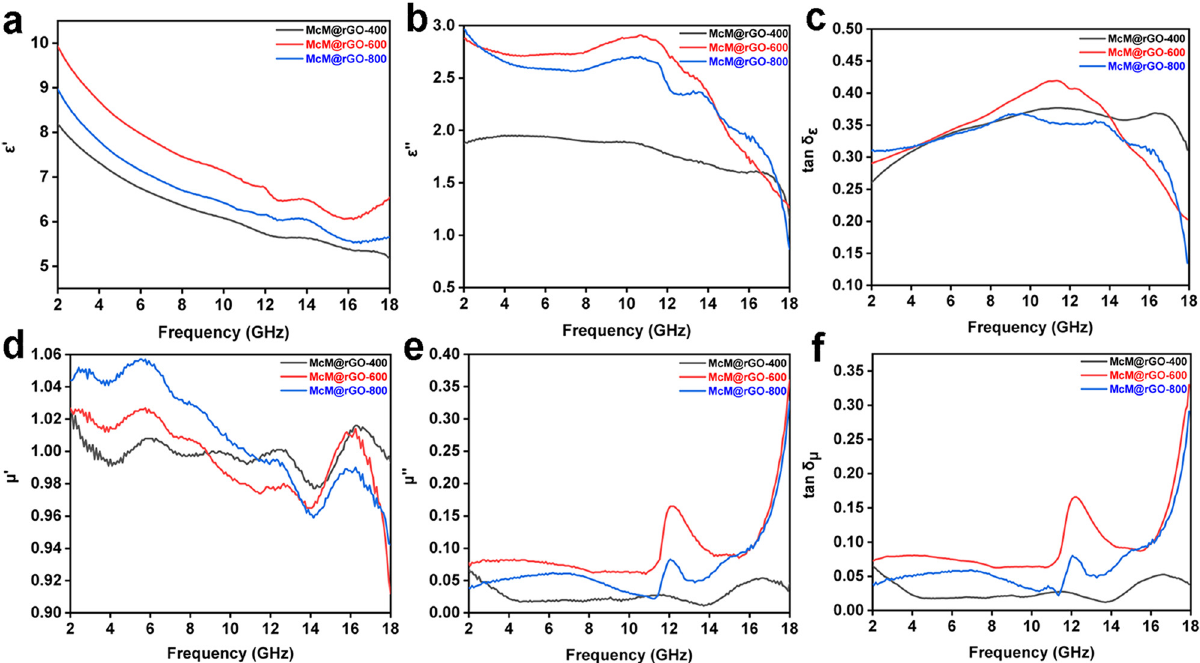
Figure 5: Frequency - dependent electromagnetic parameters of McM@rGO synthesized at di ff erent annealing temperatures. ( a ) ε ′ , ( b ) ε ″ , ( c ) tan δε , ( d ) μ ′ , ( e ) μ ″ , and ( f ) tan δμ